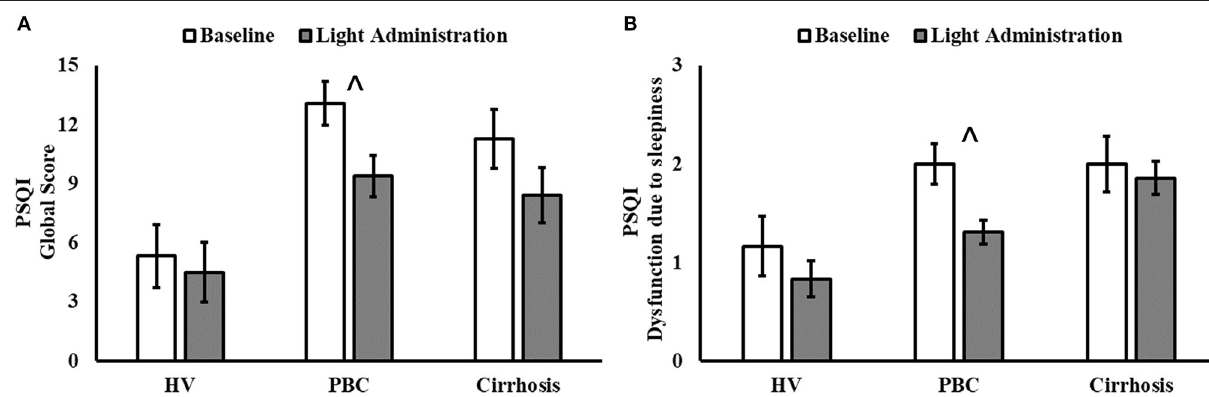
A significant reduction in PSQI Global Score was observed in patients with PBC following light administration (9.38 ± Table 1 , Figure 1A ), together with a reduction in the PSQI Component 7 (dysfunction due to sleepiness) [1.3 ± 0.5 (light) Table 1 , Figure 2A ) and earlier get-up time (06:58 ± 01:07 vs. significant differences were observed in actigraphy indices during light administration in any of the groups ( Table 2 ). However,